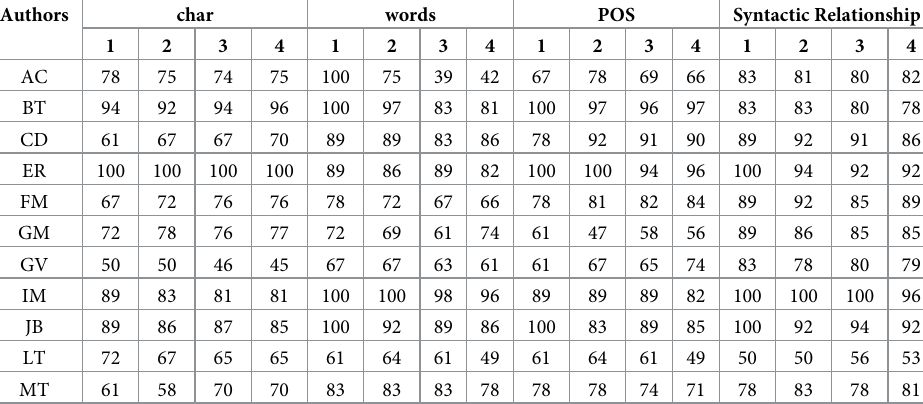
Table 8. Accuracy (%) using ALL-features with different split